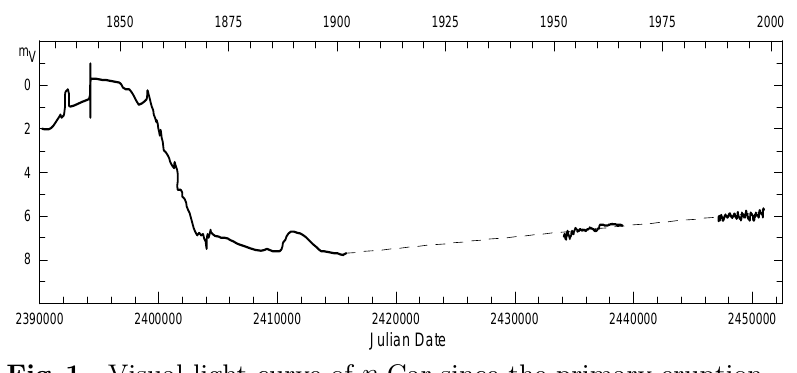
Fig. 1. Visual light curve of η Car since the primary eruption (Sterken